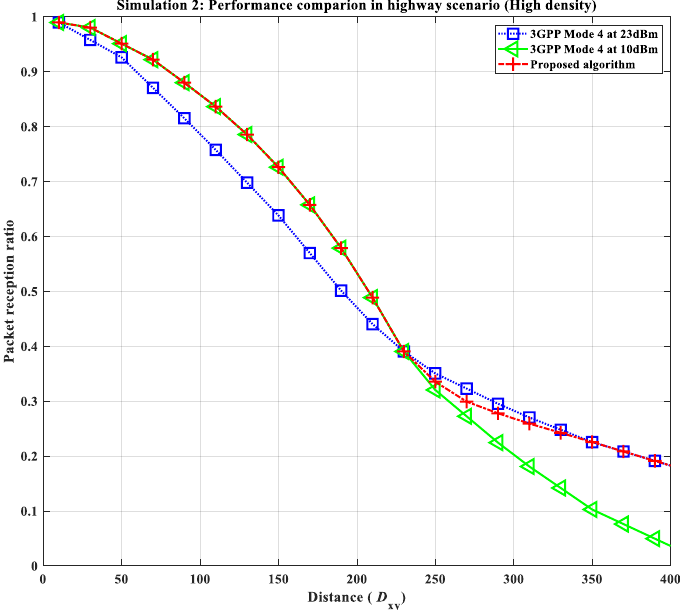
Figure 11. Packet reception ratio as a function of the distance between the transmitter and receiver ( D xy ) in a highway scenario with high tra ffi c